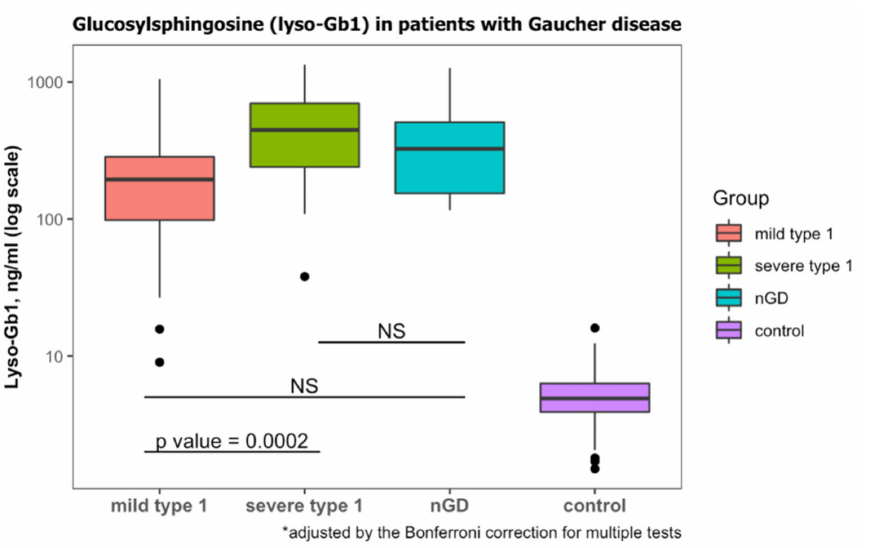
Figure 2. Lyso-Gb1 levels at diagnosis of GD. Classification of mild type 1, severe type 1 and neuronopathic GD (nGD) was based on genotypes. Lyso-Gb1 levels of subjects with wild-type GBA1 were considered to be the control. NS, non-significant. Black dots represent the